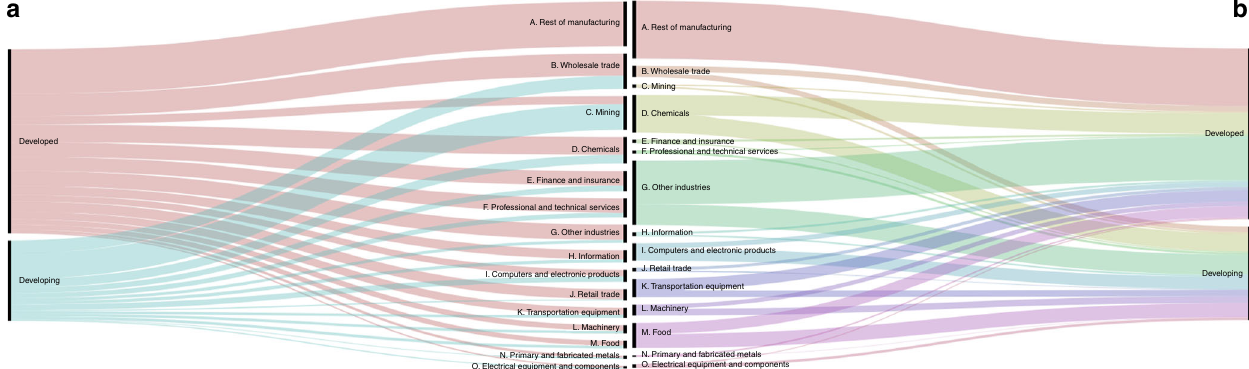
Fig. 6 Shares of US-MNEs ’ value added and producer footprint by sectors (%). Value added generated ( a ) by US-MNE abroad is 709,686 million $ in developed economies (65%) and 389,634 million $ in developing economies (35%). The carbon footprint (panel b) of US-MNE af fi liates is 265,175 Kt CO 2 (52%) in developed countries and 243,039 Kt CO 2 in developing countries (48%). See Supplementary Data 6. This Figure has been created using the open source data visualization framework RAW Graphs, developed in Mauri et al.